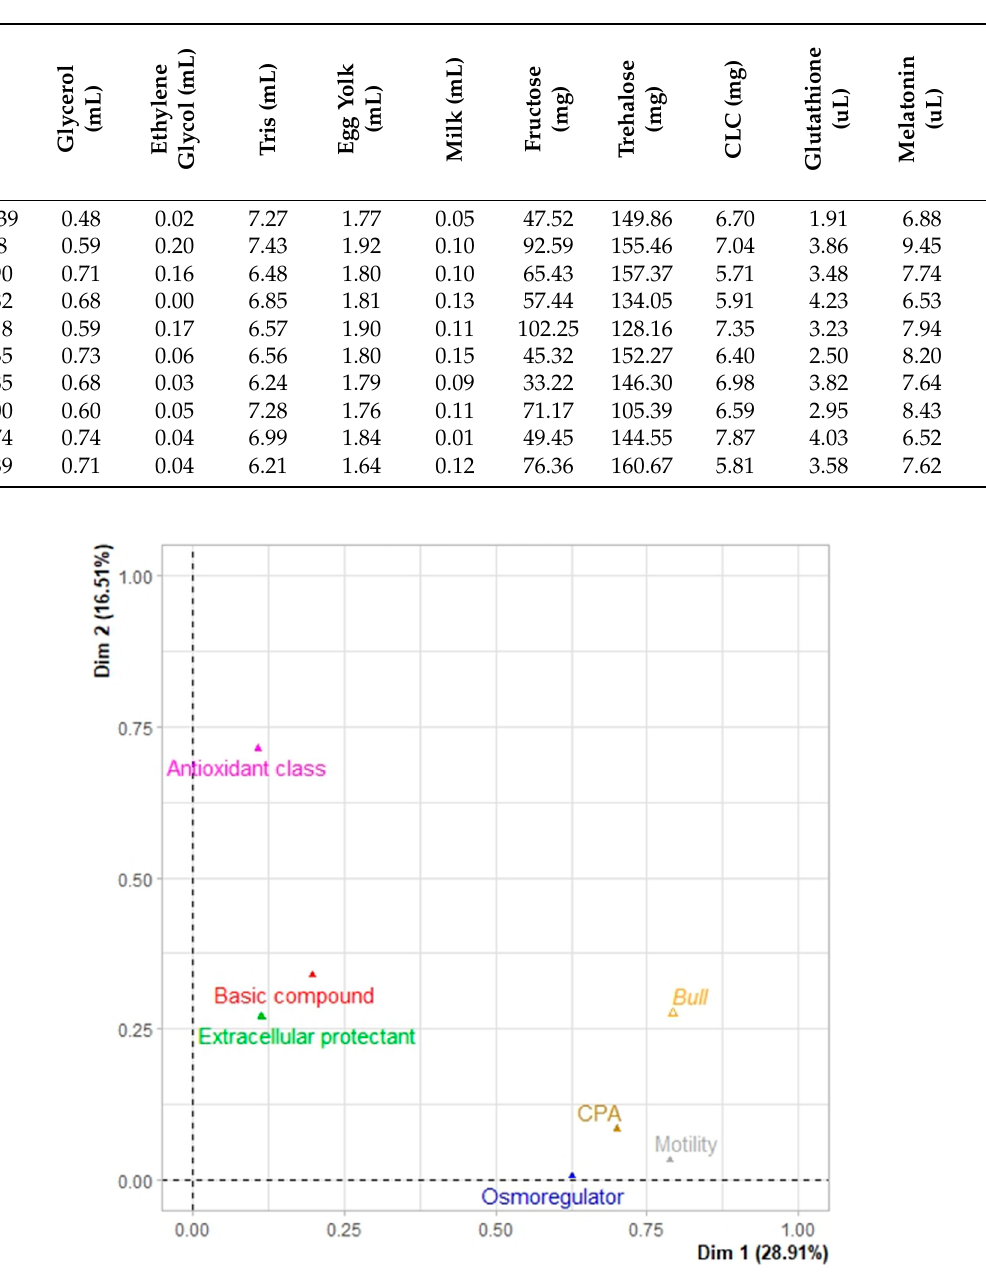
Table 6. The components and concentrations of the ten top extenders for progressive motility driven by the Monte Carlo simulation.